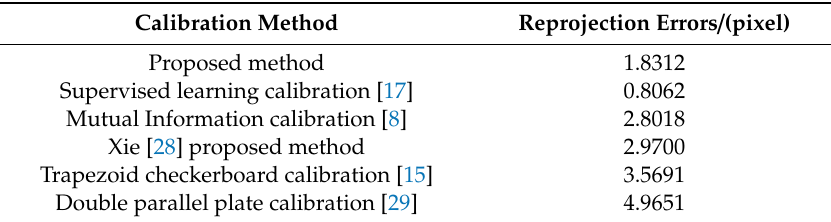
Table 5. Reprojection errors of di ff erent